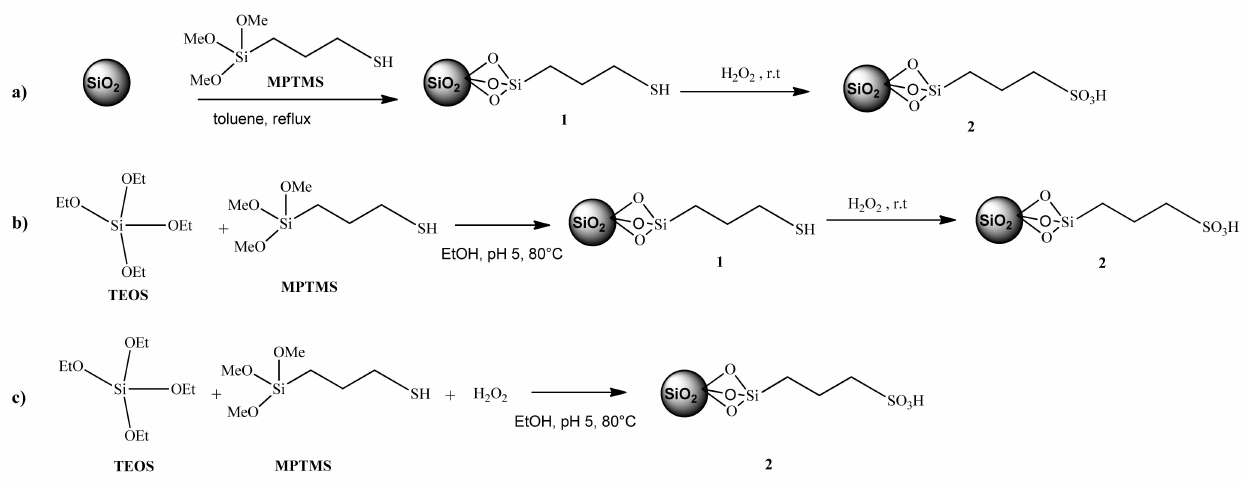
Figure 1. Synthesis of propyl sulfonic silica by three different methodologies: ( a ) grafting, ( b ) co-condensation and ( c ) in situ oxidation